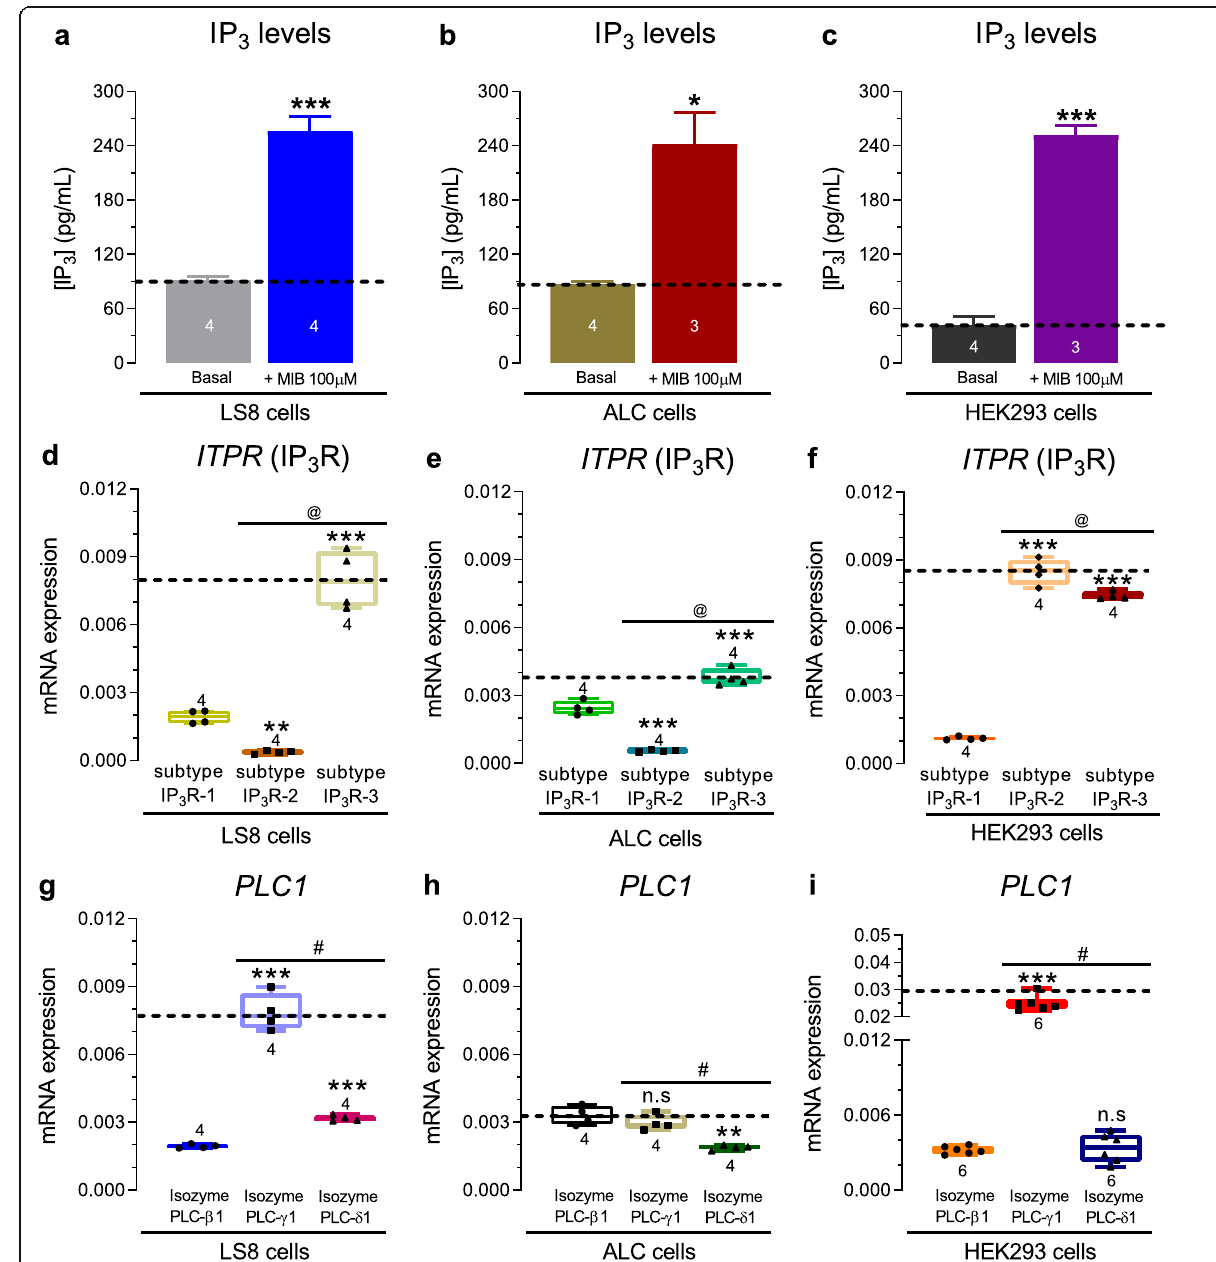
Fig. 2 IP 3 content and expression of IP 3 receptor subtypes. a Quantification of IP 3 content in LS8 cells. b Quantification of IP 3 content in ALC cells. c Quantification of IP 3 content in HEK-293 cells. In all cells, quantification was performed before and after incubation with mibefradil (100 μ M, 3 – 4 min). d-f Relative mRNA expression of the ITPR gene encoding the IP 3 R subtypes 1 – 3 quantitated by qPCR in each cell type. Data represent the mean ± SEM of 3 – 4 independent experiments. Data were analyzed by one-way ANOVA followed by Tukey ’ s multiple comparison post-hoc test. * P < 0.05; ** P < 0.01 or *** P < 0.001 vs. IP 3 R-1 group; @ P < 0.05 vs. IP 3 R-2 group; n.s.,